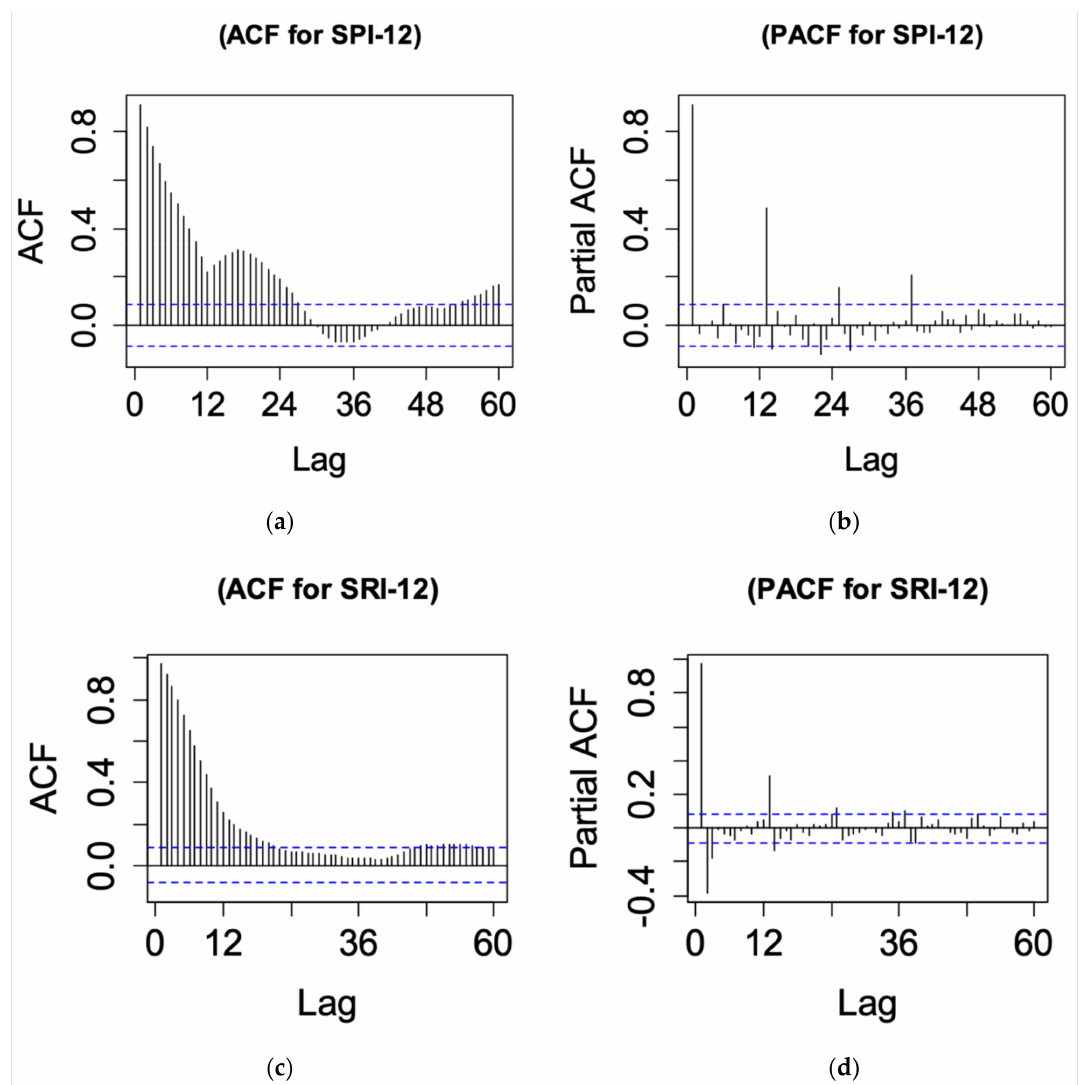
Figure 5. ACF and PACF correlograms and 95% confidence limits for stochastic monthly series for the Wadi Ouahrane basin ( a – d